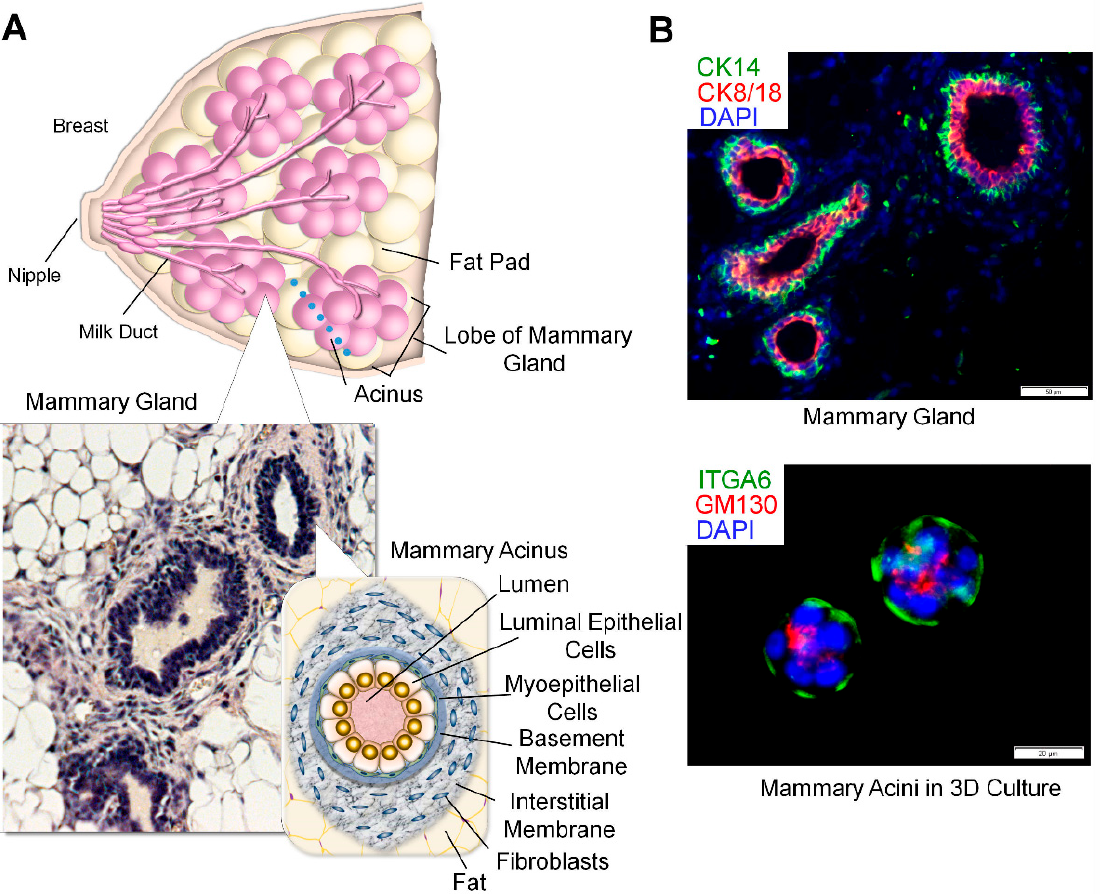
Figure 1. The architecture of mammary glands. ( A ) (Top) Exocrine glandular structure of the mammary gland embedded in the fat pad and connective tissue. (Bottom left) Cross-sectioned mammary gland stained with hematoxylin and eosin. (Bottom right) Structure of mammary acinus, milk-producing unit, composed of luminal epithelial cells and myoepithelial cells surrounded by the basement membrane (BM). Each acinus is embedded in the interstitial membrane (connective tissue) and fat tissue. ( B ) (Top) Cross-sectioned mammary gland stained with antibodies against cytokeratin 14 (green, basal cells) and cytokeratin 8/18 (red, luminal cells). (Bottom) Mammary acini formed by non-malignant human MECs, HMT-3522 S1, in 3D culture with Matrigel and stained with antibodies against α 6 integrin (green, basal marker) and GM130 (red, apical marker). Nuclei were counterstained with DAPI (blue).